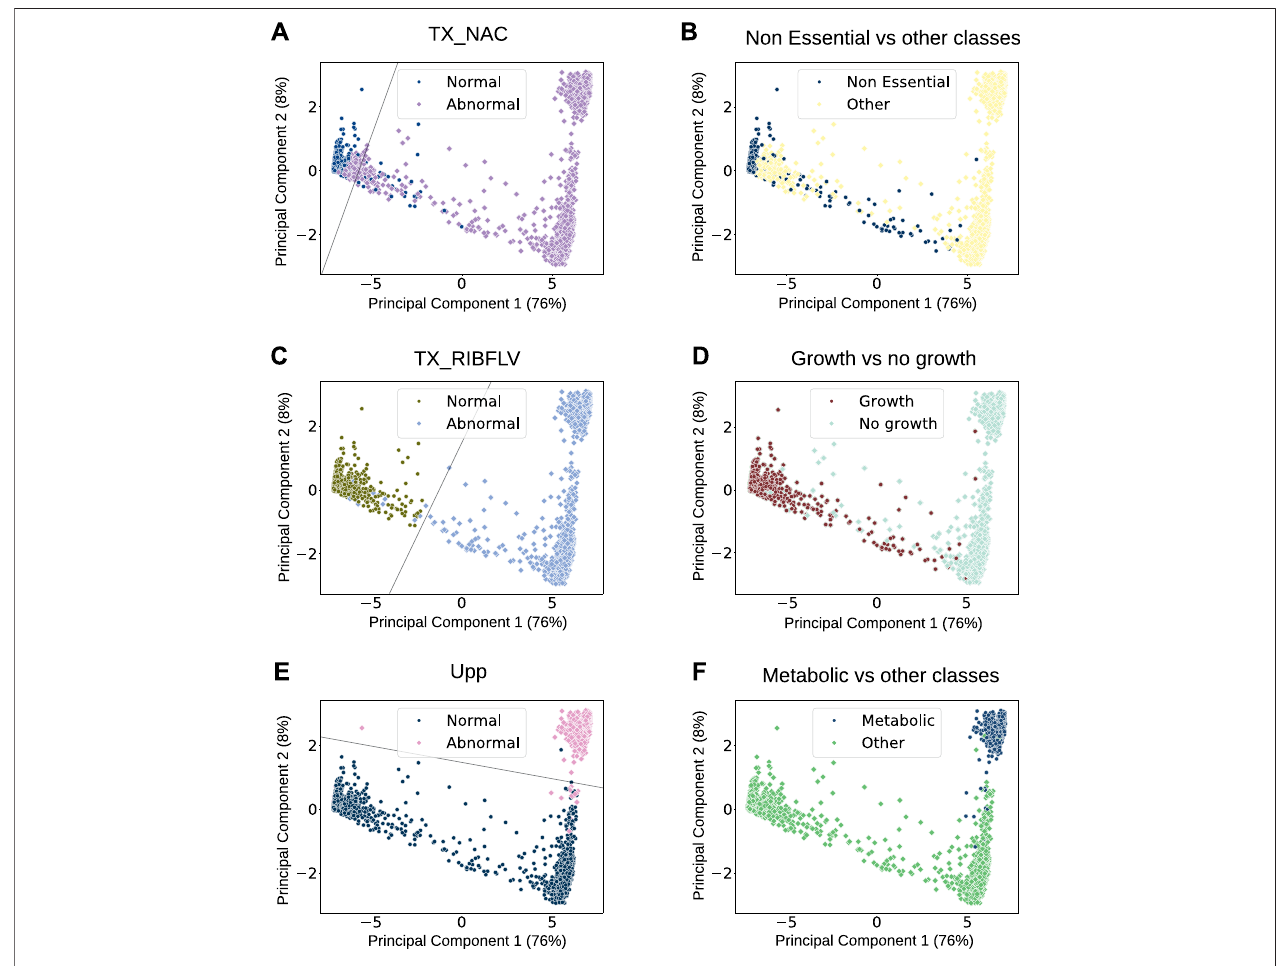
FIGURE4| Scatter plotsofall fl uxpro fi les reduced toa2D feature space.On theleft [plots (A,C, E) ],each point islabelled withthebehaviour (normalor abnormal) of a single reaction that is a driver node. The lines shown decision boundaries for support vector machines (SVMs); models that form a hyperplane to linearly separate different classes of data, where in this case the classes will be fl ux pro fi les where the speci fi ed reaction behaves normally, and fl ux pro fi les where the speci fi ed reaction behavesabnormally.Thereactionsarereferredtousingtheiridenti fi ersthatareusedinthemodel.Ontheright[plots (B,D,F) ],eachpointshowsthemanuallabelof thephenotypicclassesthatcorrelatewiththebehaviourofthereactionsontheleft — thesimulationsthatshownormalbehavioursofTX_NAChavea92%correlationwith those that are manually classi fi ed as non-essential; those that show normal behaviours of TX_RIBFLV show a 95% correlation with those that are manually classi fi ed as non-essential, DNA, or septum phenotypes (which all show cell growth), and those that show abnormal behaviours for Upp show a 97% correlation with those that are manually classi fi ed as metabolic.